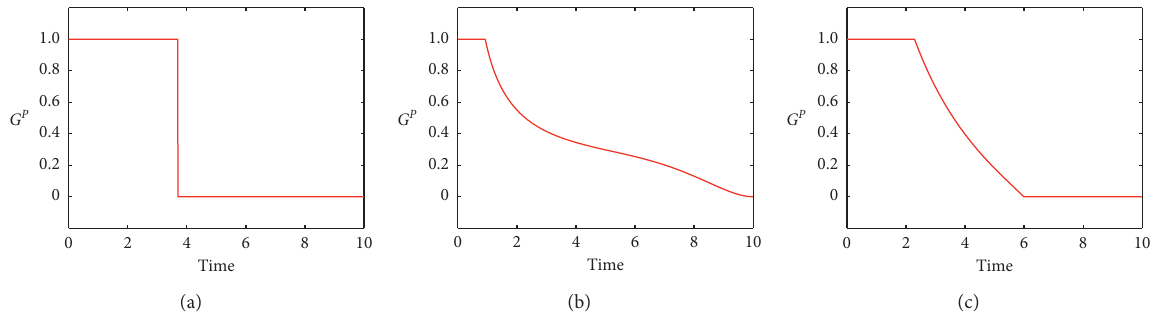
Figure 4: The promising rumor-containing scheme G p for three pairs of ( θ ( x ) � θ 2 θ 1